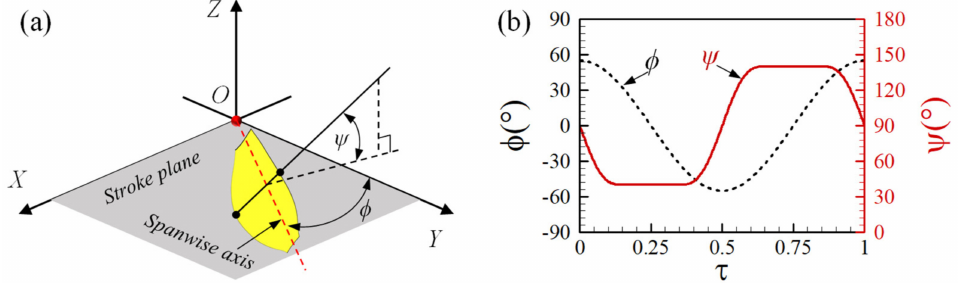
Figure 2. ( a ) Coordinate system and two angles ( ψ and φ ) of the flapping motion; ( b ) time course curves of ψ ( τ ) and φ ( τ ) in a flapping